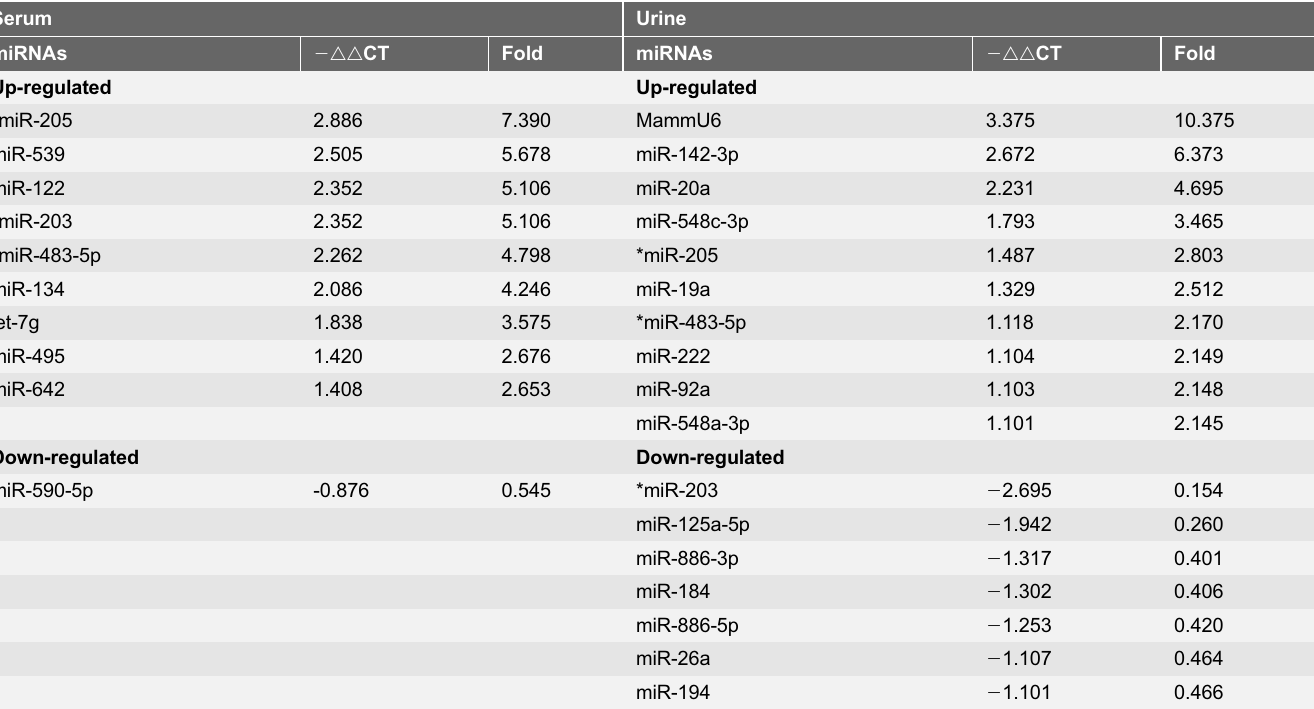
Table 2. miRNAs differentially expressed in serum and urine of childhood AD compared to controls (P , 0.05). Serum Urine